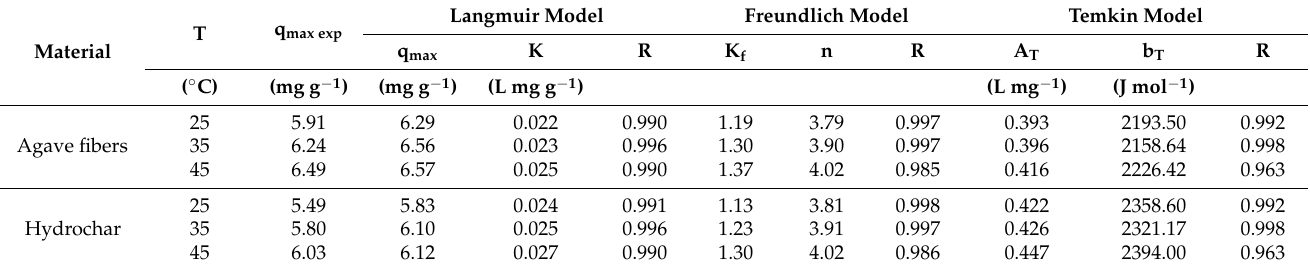
Table 4. Equilibrium constants of the mathematical models proposed to describe the adsorption process of DB-86 on the adsorbent prepared from agave bagasse fibers.